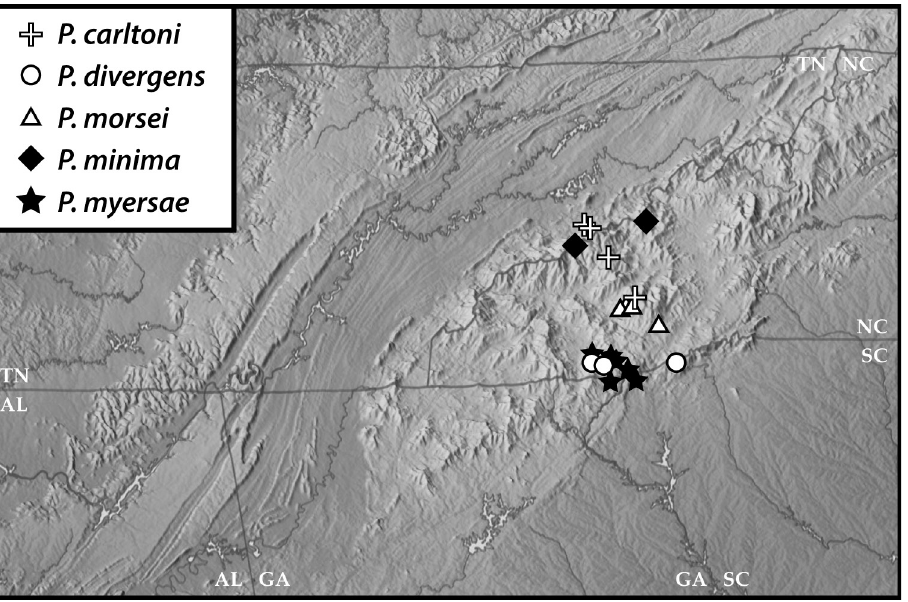
Figure 49. Map of southern Appalachia with specimen records for P. carltoni , P. divergens , P. morsei , P. minima , and P. myersae